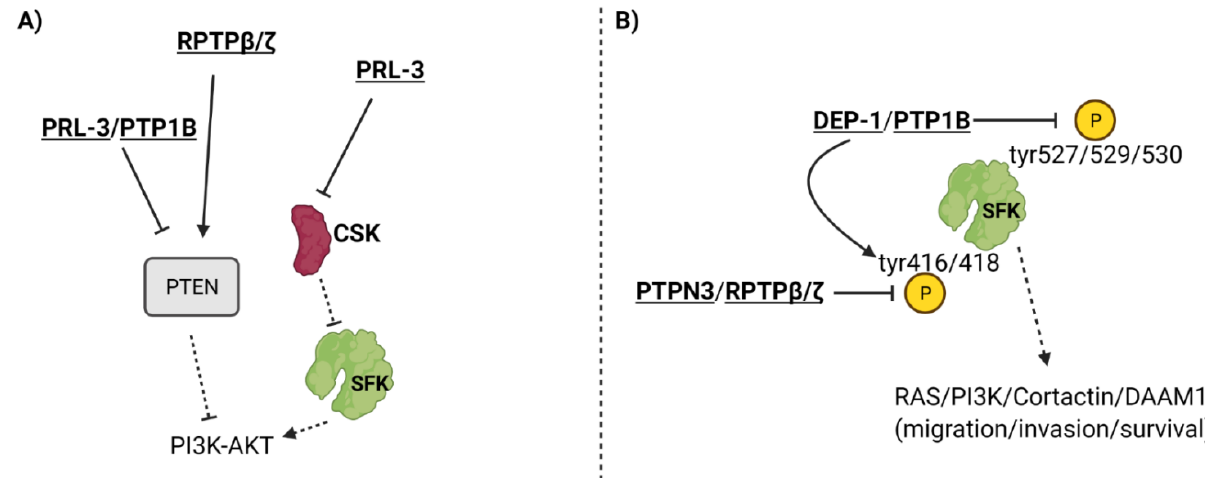
Figure 2. PTPs that impact SFKs and PTEN. PTPs can influence PTEN, CSK (Src Kinase inhibitor) (Panel A ), and phos- phorylation of the Tyr527/529/530 inhibitory residues and the Tyr416/418 catalytic residues of the Src family of kinases (Panel B ). To see how PTEN and SFK function in signaling cascades, refer to Figure 3. For a more in-depth discussion of the mechanism of action for each PTP, refer to Table 2. Table 2. PTPs that impact SFKs and PTEN to influence PI3K-AKT, Cortactin, and DAAM1 dynamics. Oncogene (O)/Tumor Cellular/Molecular Function Suppressor